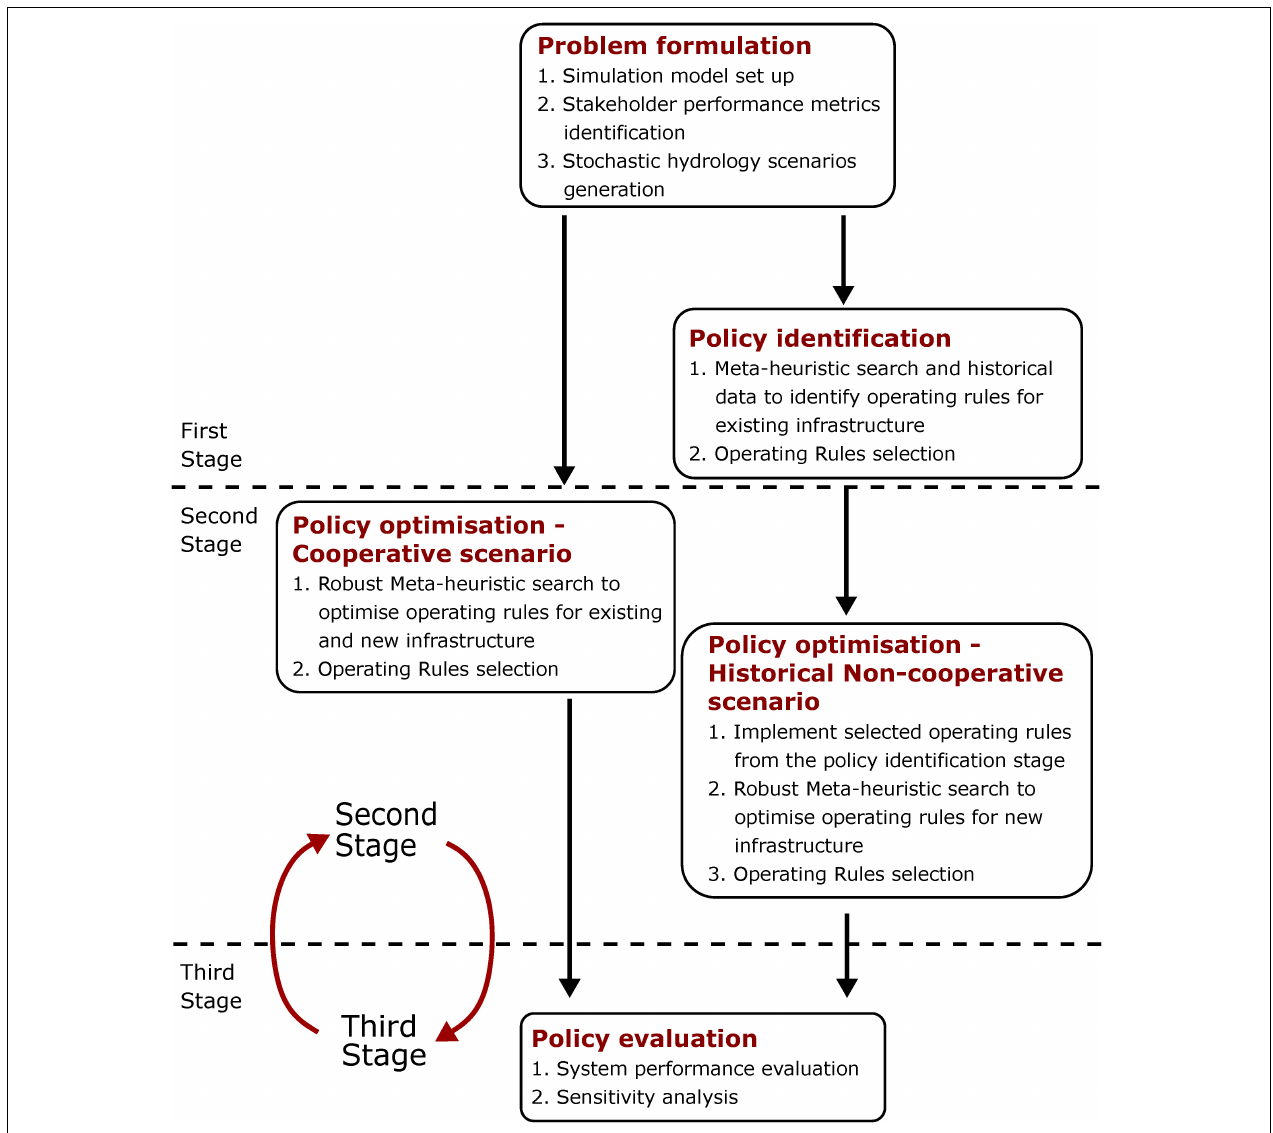
FIGURE 2 | Schematic of the proposed